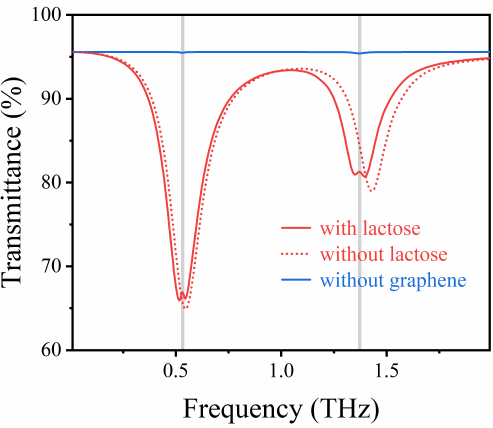
Figure 2. Transmission spectra of vertically incident TM waves with or without lactose AIGS.